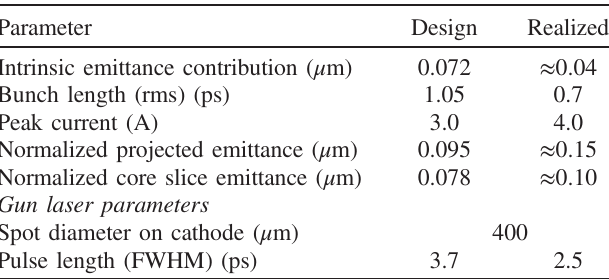
TABLE II. Design parameters of the SwissFEL Injector Test Facility for the low-charge mode (10 pC bunch charge), as far as different from the high-bunch-charge mode, with comparison to typically realized values. (Systematic compression studies have only been carried out for the high-charge